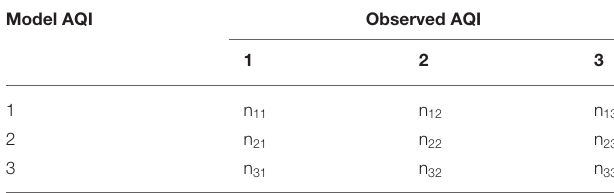
TABLE 2 | A 3 × 3 contingency table for forecast skill. Model